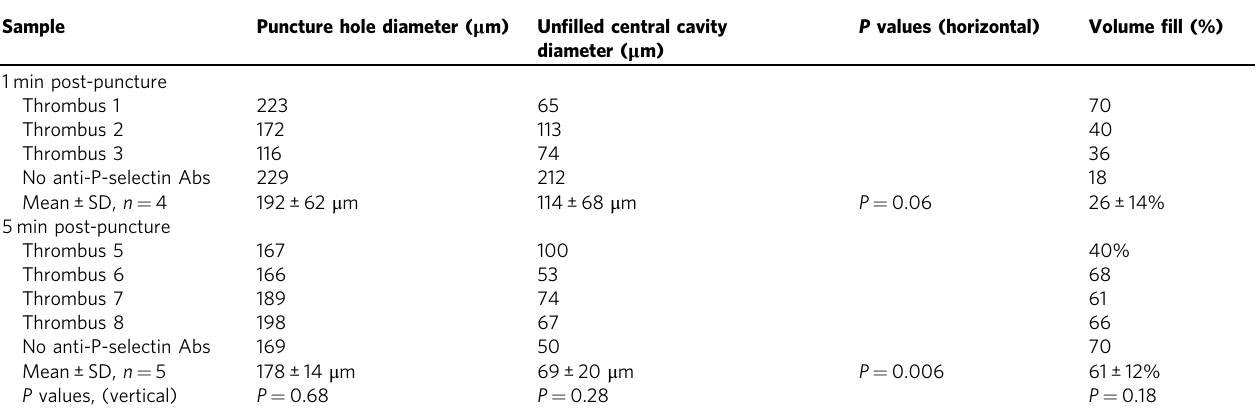
Table 1 Extent of puncture hole thrombus fi ll.